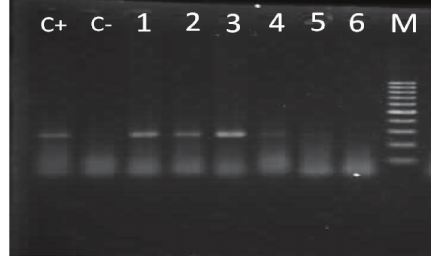
Figure 3: PCR results of beta-globin gene: in terms of amplification, samples1,2,and3arepartofpositivebeta-globingene(260 bpband) and samples 4, 5, and 6arenegative. C+and C − indicatepositiveand negative controls, respectively, and M represents the DNA marker. Figure 4: PCR results of BLLF1 gene of EBV: samples 2, 4, and 5 are